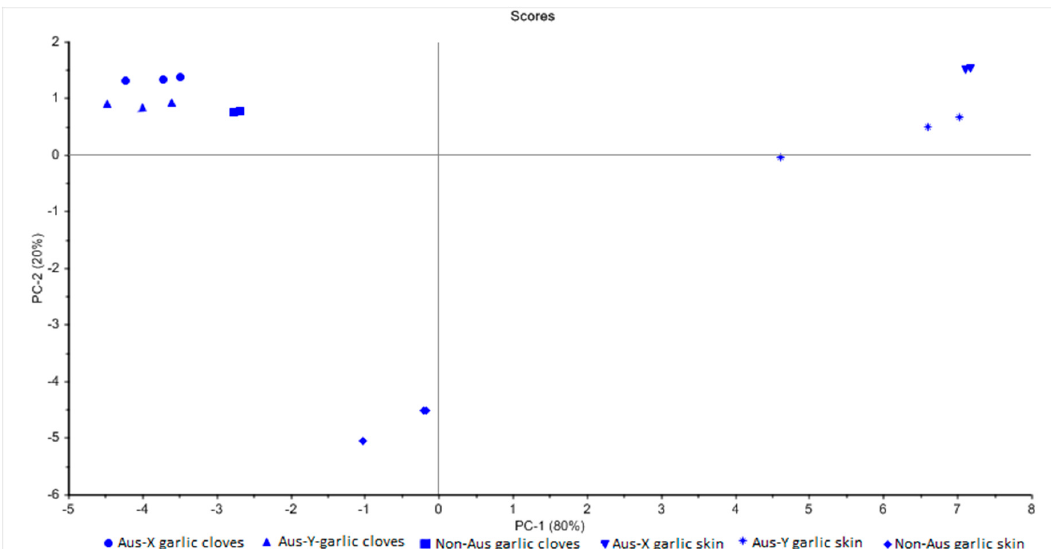
Figure 4. Principal component analysis (PCA) score plot classifies the samples into three distinguished groups (Aus: Australian).